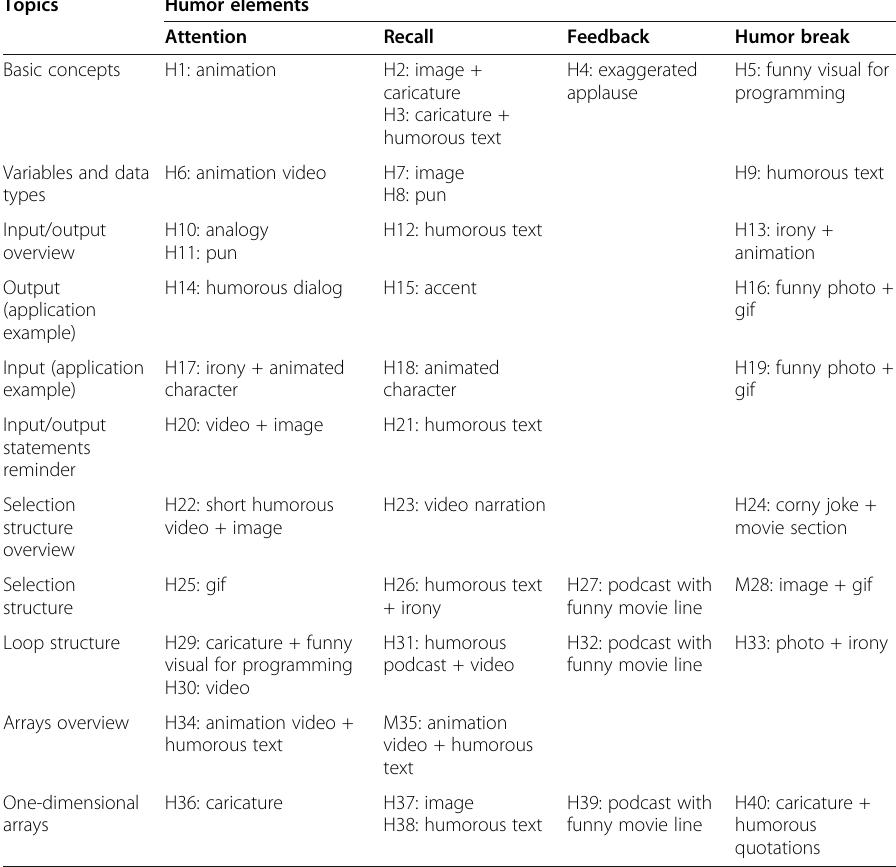
Table 3 Distribution of humor elements by subjects Topics Humor elements Attention Recall Feedback Basic